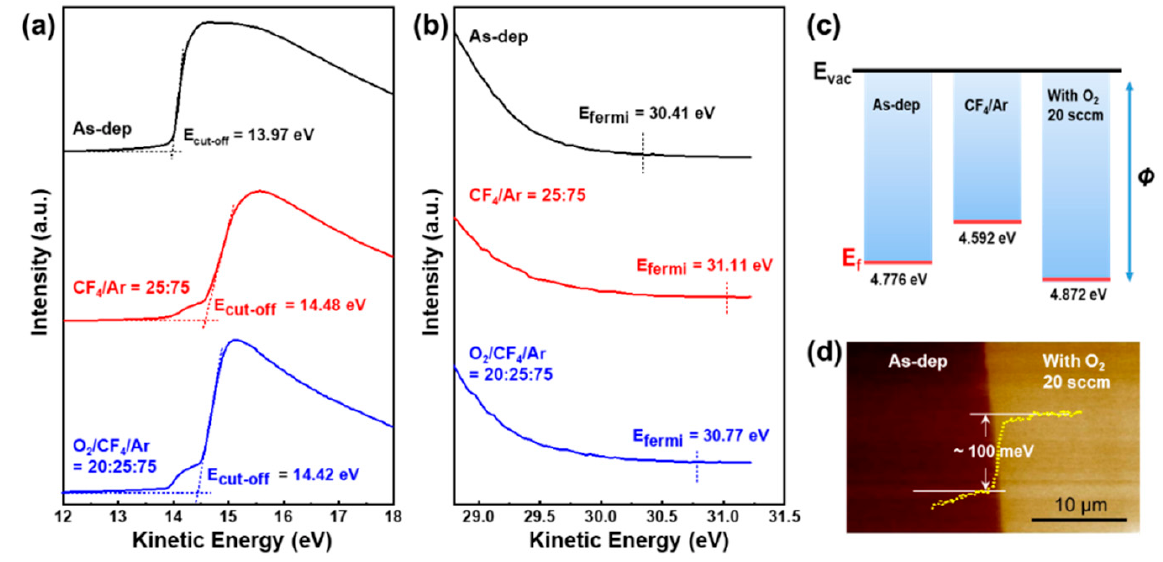
Figure 5. UPS spectra of ( a ) secondary electron cutoff ( E cut-off ) ( b ) Fermi level energy ( E fermi ) region. ( c ) Bar charts for variations of the work function of IGZO thin films, depending on the etching con- dition and ( d ) KPFM image to compare as-deposited thin-films and those etched using O 2 /CF 4 /Ar plasma.